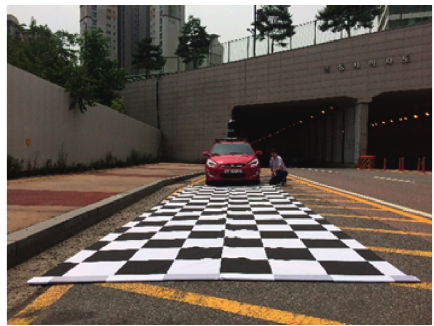
Figure 3: Camera extrinsic parameter